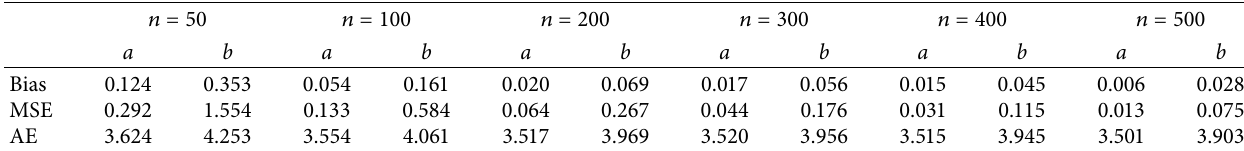
Table 5: Biases, MSEs, and AE for scenario-IV.